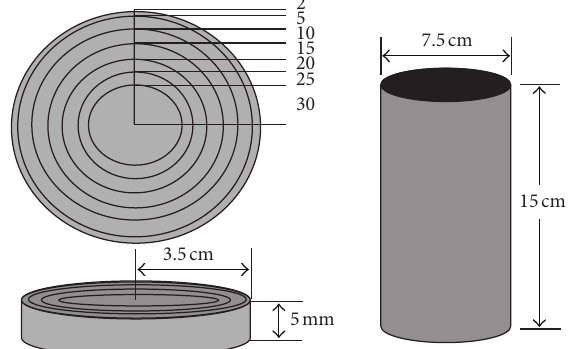
F 1: Sketch of specimens used to extract and determine chlo-